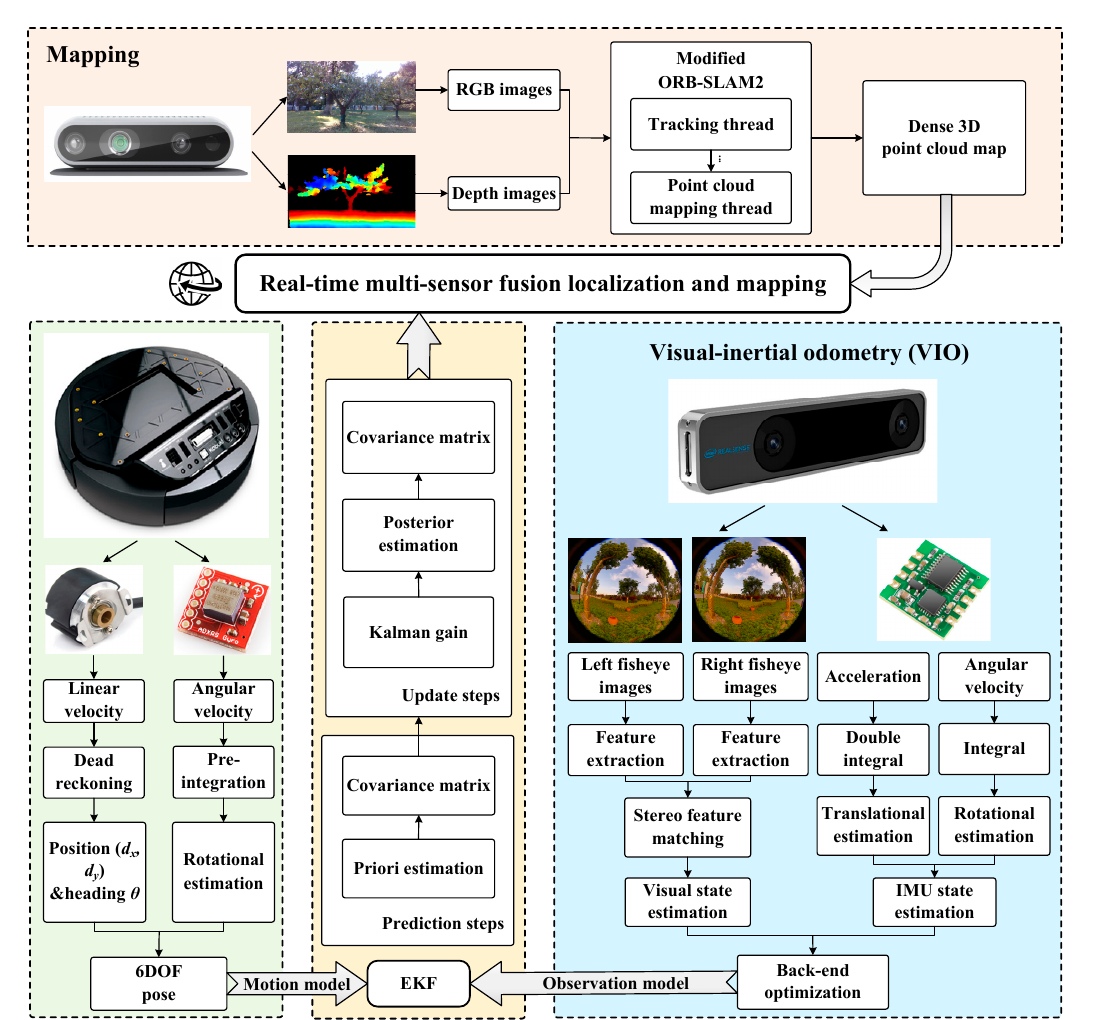
Figure 4. The overall framework of the proposed